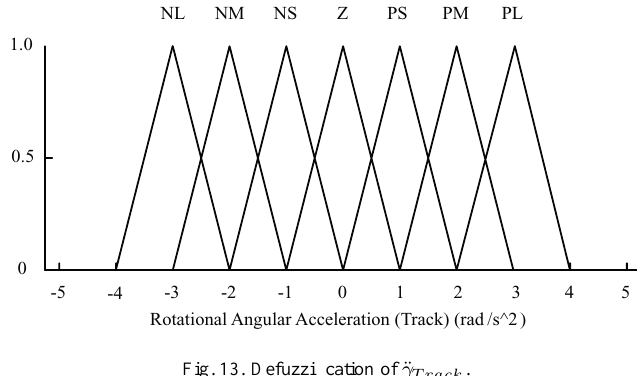
Fig. 13. Defuzzification of ¨ γ Track .